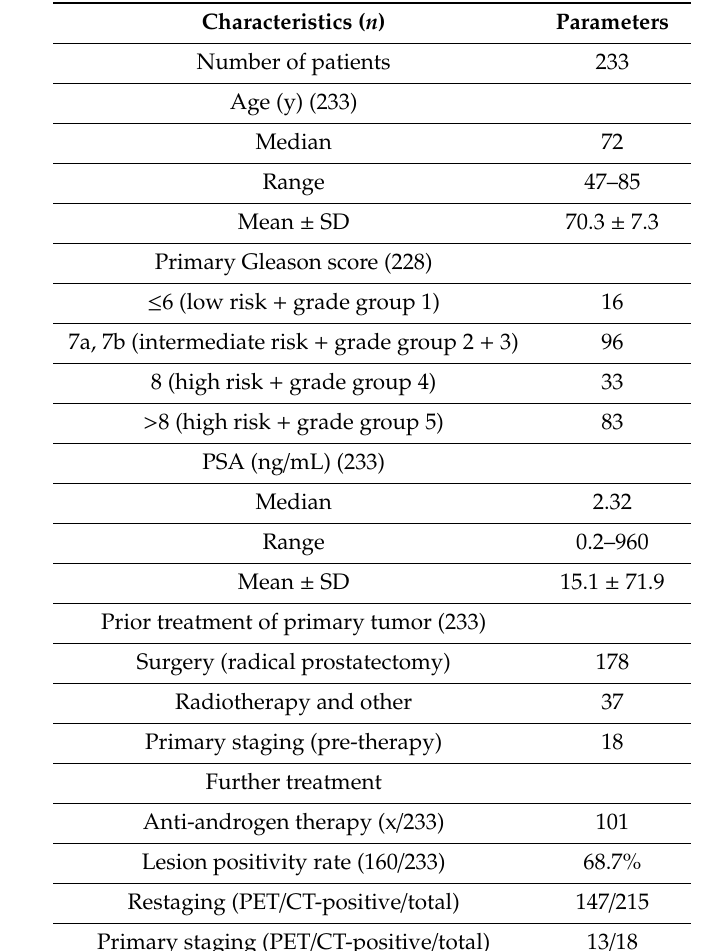
Table 1. Patient